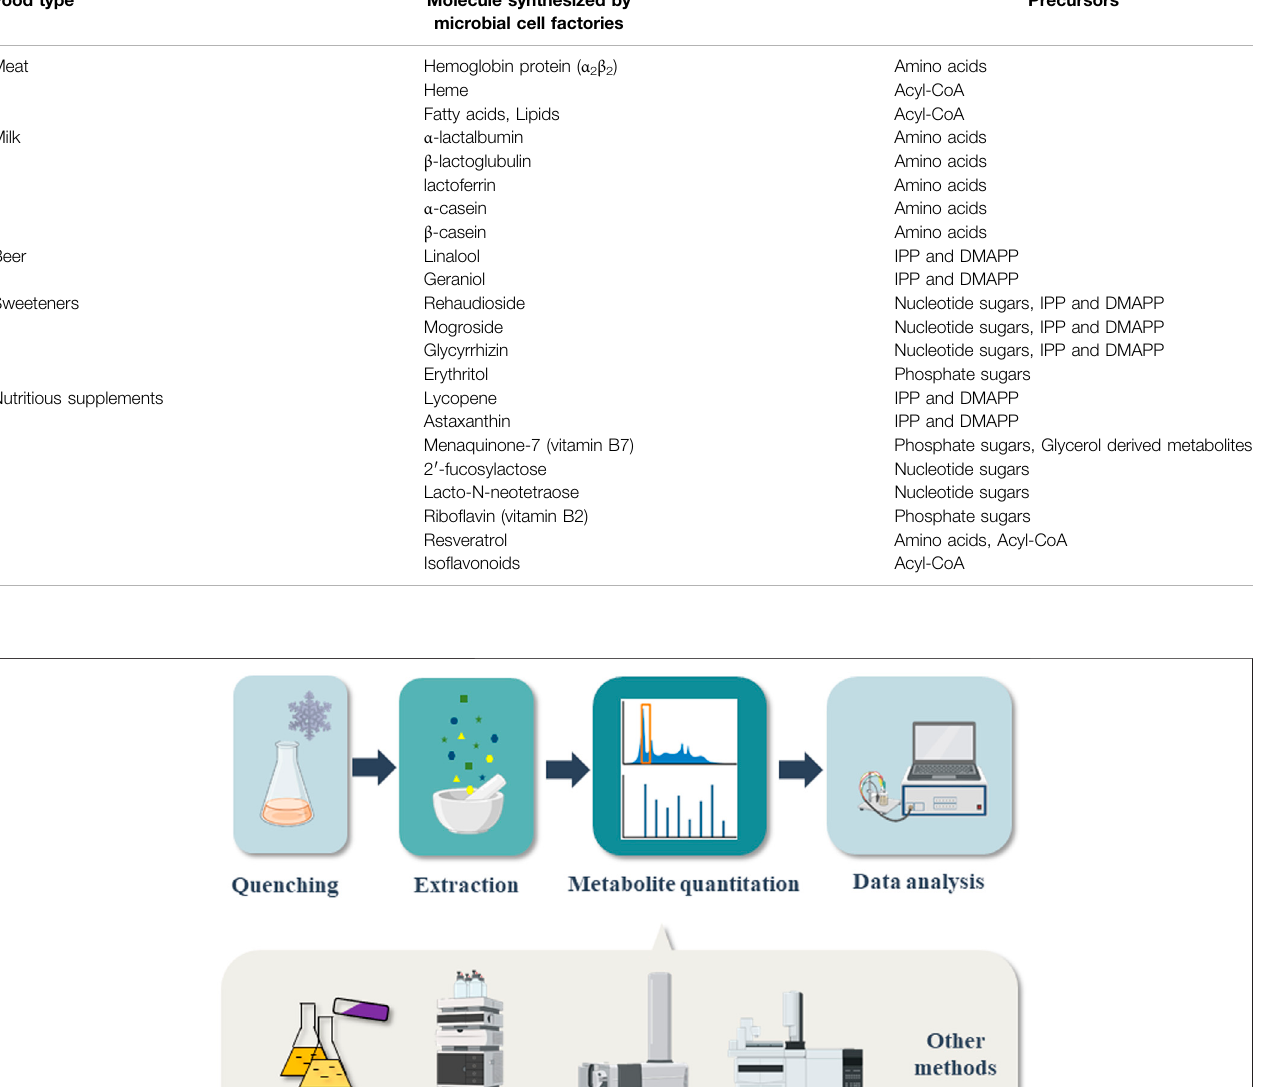
TABLE 1 | Examples of biosynthetic food and their corresponding precursors. Food type